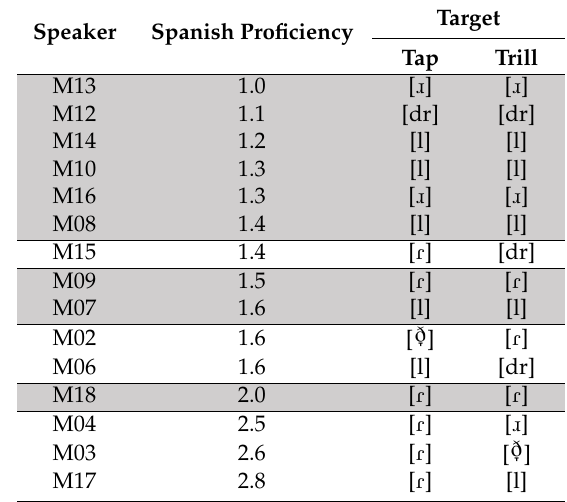
Table 5. Comparison of the most frequently produced segment for tap and trill targets, by L1 Mandarin–L2 English–L3 Spanish speakers who could not yet produce the trill ( n = 15), ordered by Spanish oral proficiency. Shaded cells indicate which speakers produced the same substitution for both